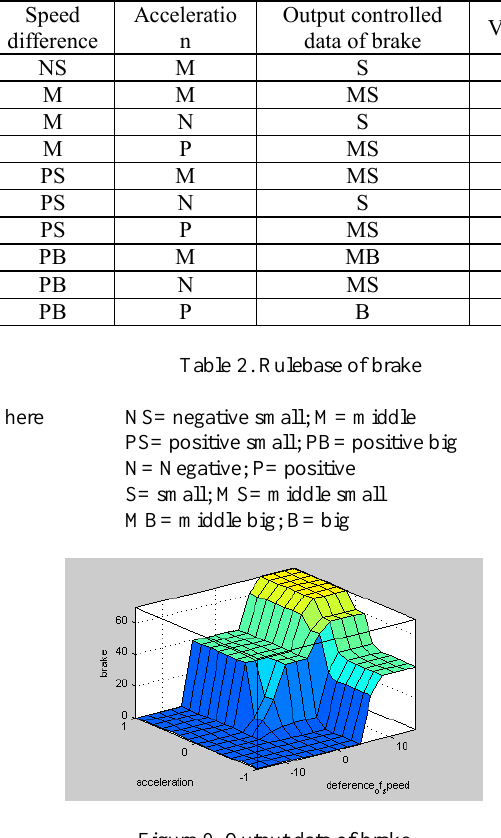
Figure 9. Output data of